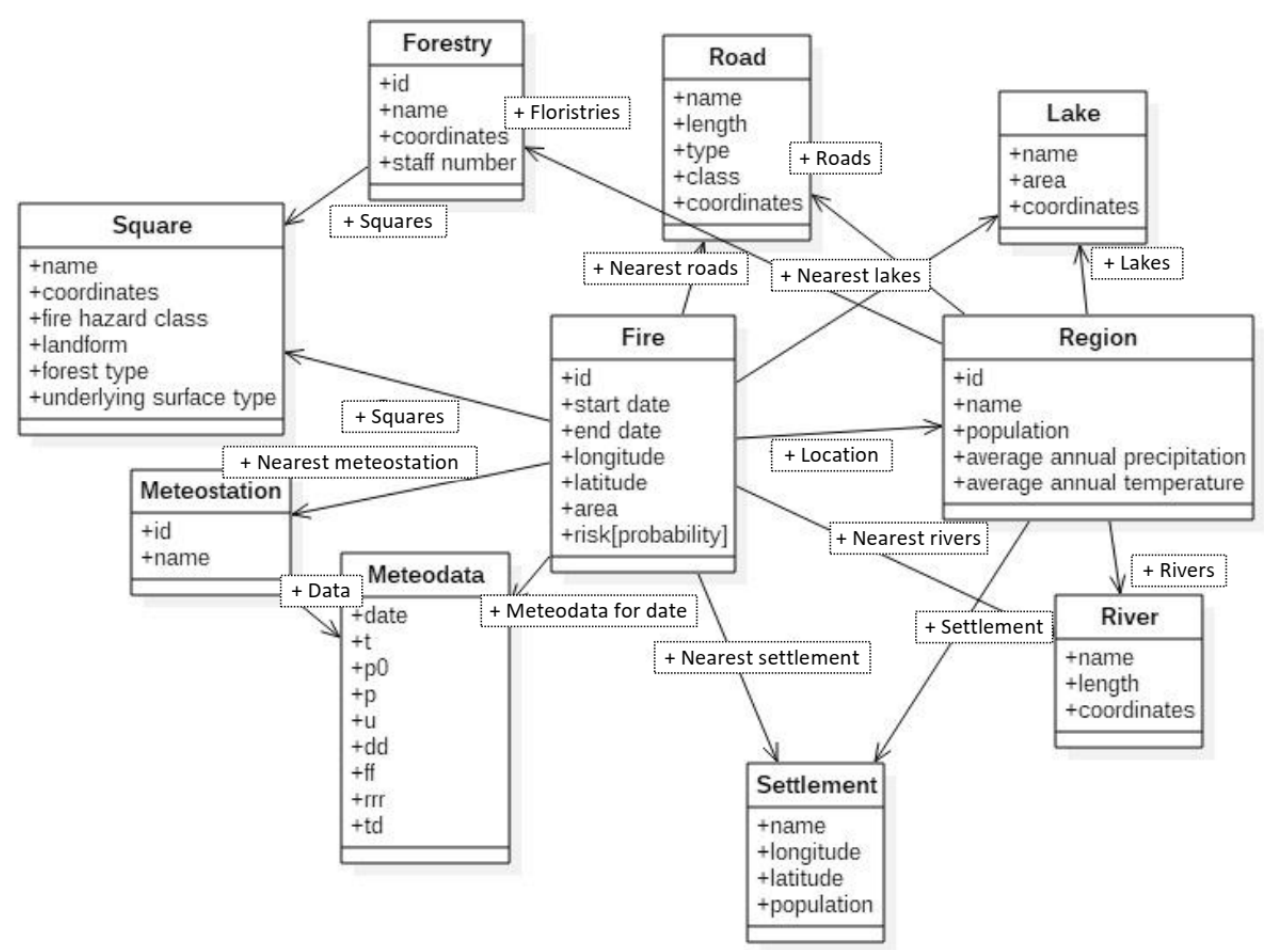
Figure 5. A fragment of the conceptual model of the